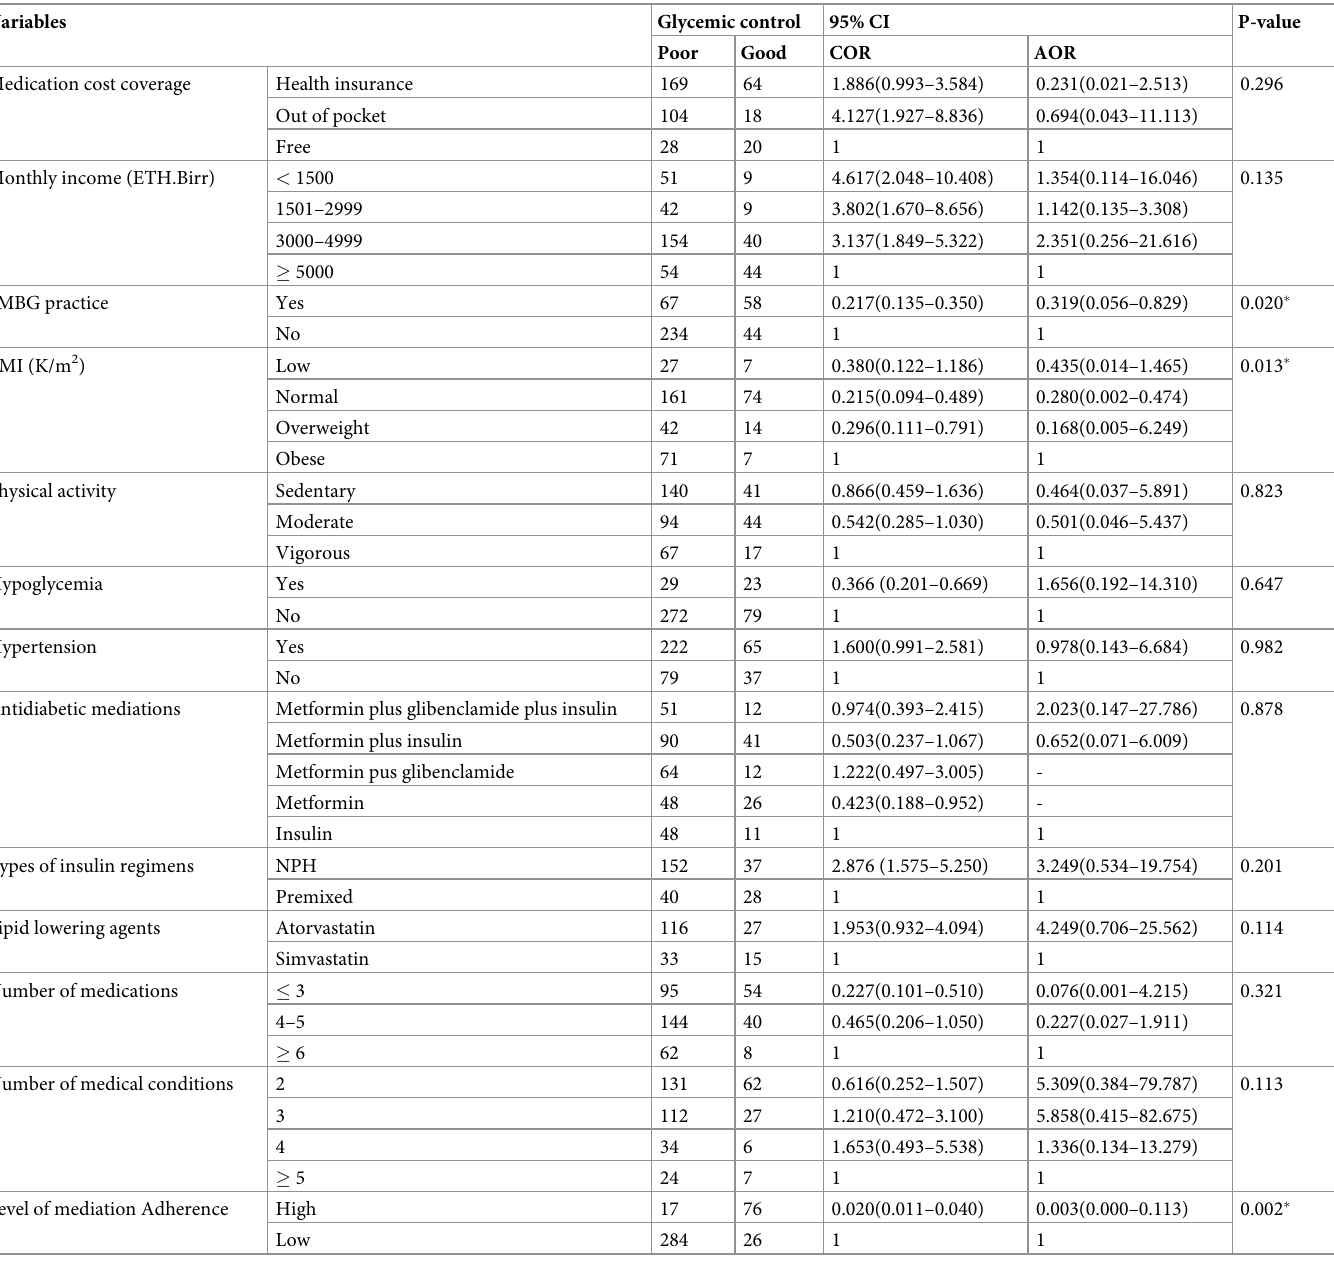
Table 5. Association of medication adherence and other predicted variables with glycemic control in T2DM patients with comorbidity.